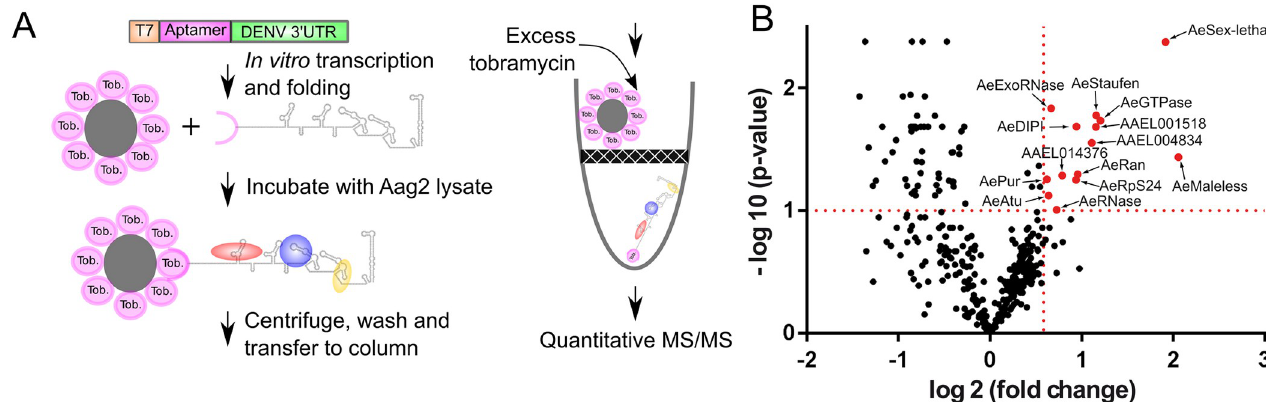
Fig 1. Application of RNA-affinity chromatography to identify Aedes aegypti proteins that interact with DENV2 3’UTR. (A) Schematic of the RNA- affinity chromatography coupled with quantitative mass spectrometry (MS). (B) Identification of the DENV2 3’UTR-bound proteins. Of the 385 proteins detected, 14 interacted more than 1.5 fold (p < 0.1) with DENV2 3’UTR, as compared to the control RNA. Interacting proteins are shown in red and their names are indicated with an arrow.